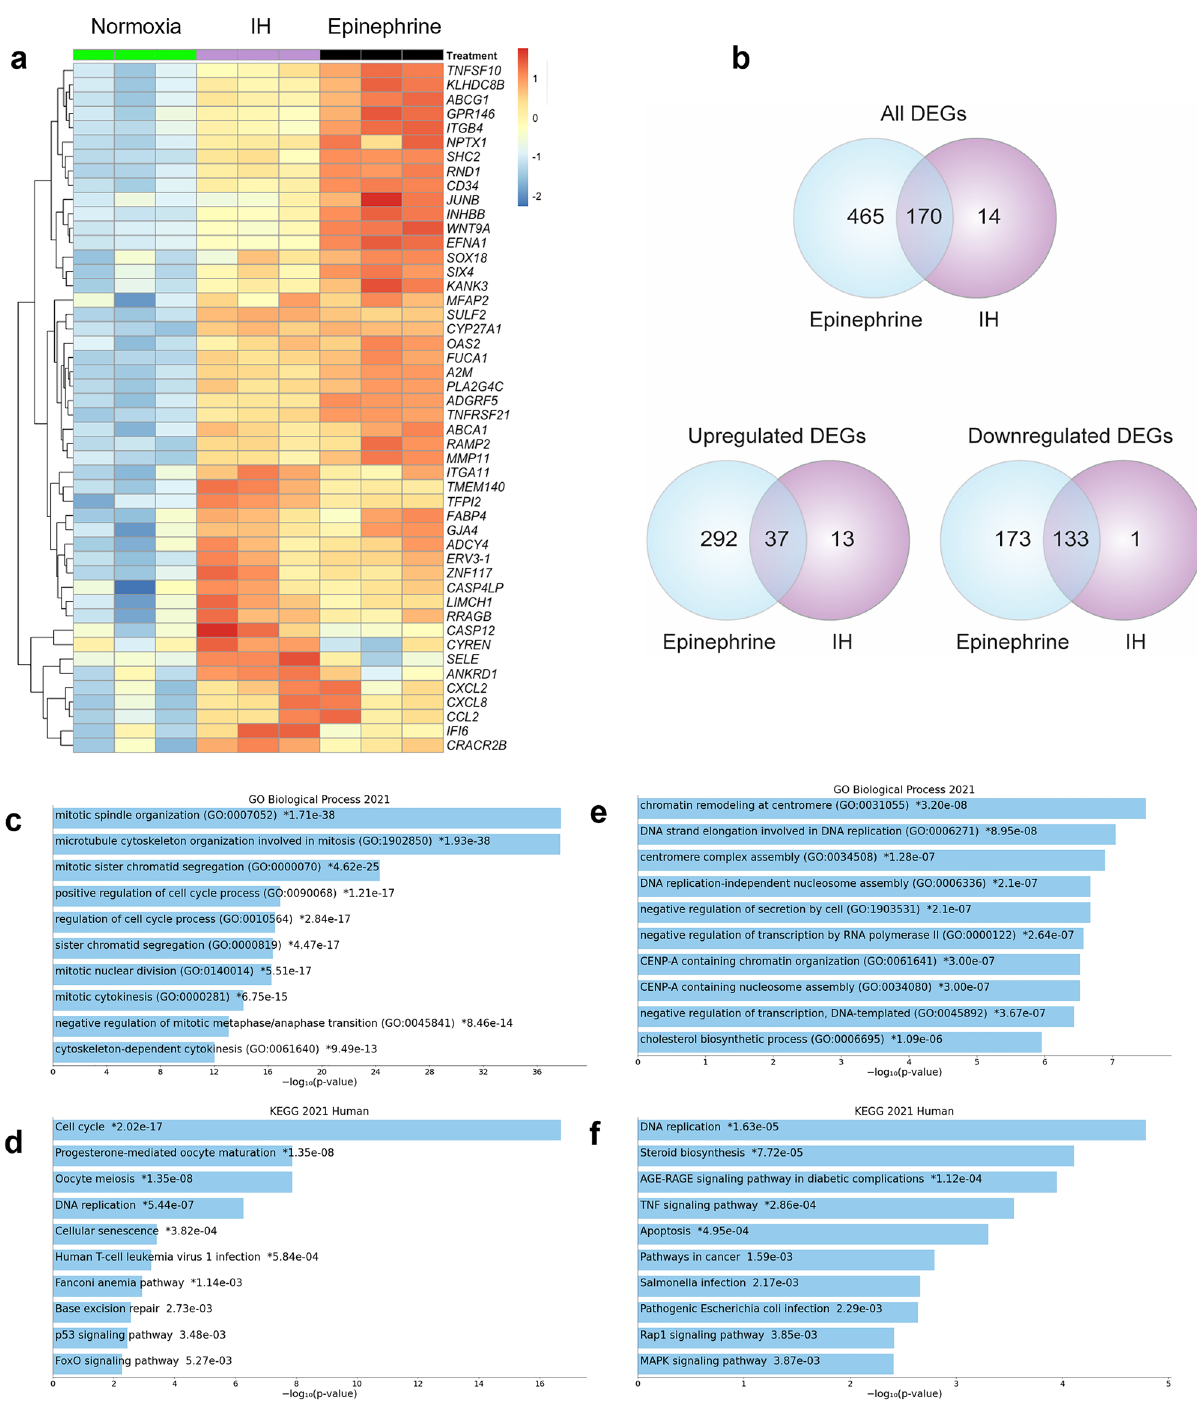
Figure 3. Epinephrine induces significantly higher number of DEGs compared to IH in human aortic endothelial cells. Differentially expressed gene profiles of HAECs, which were treated with epinephrine (10 µM) under normoxia or were exposed to 60 cycles of IH (5%-20% O 2 ) perfusion system, were comparatively analyzed. ( a ) Heatmap of top significantly upregulated genes by IH in normoxia controls and IH- or epinephrine-treated HAECs. Z-score normalized expression values are shown in heat map, scale bar represents logFC values. “Pretty heatmaps R pheatmap package” from Z-score normalized expression values. https:// cran.r- proje ct. org/ web/ packa ges/ pheat map/ pheat map. pdf ( b ) Venn diagrams show differentially expressed genes (absolute fold change ≥ 2 and p value ≤ 0.05) in epinephrine-treated normoxic ECs (635 DEGs), and IH-exposed HAECs (184 DEGs). GO biological process ( c ) and KEGG pathway ( d ) enrichment analysis of gene set that were common between IH and epinephrine by Enrichr gene set search engine. GO biological process ( e ) and KEGG pathway ( f ) enrichment analysis of gene set that were specific to epinephrine by Enrichr gene set search